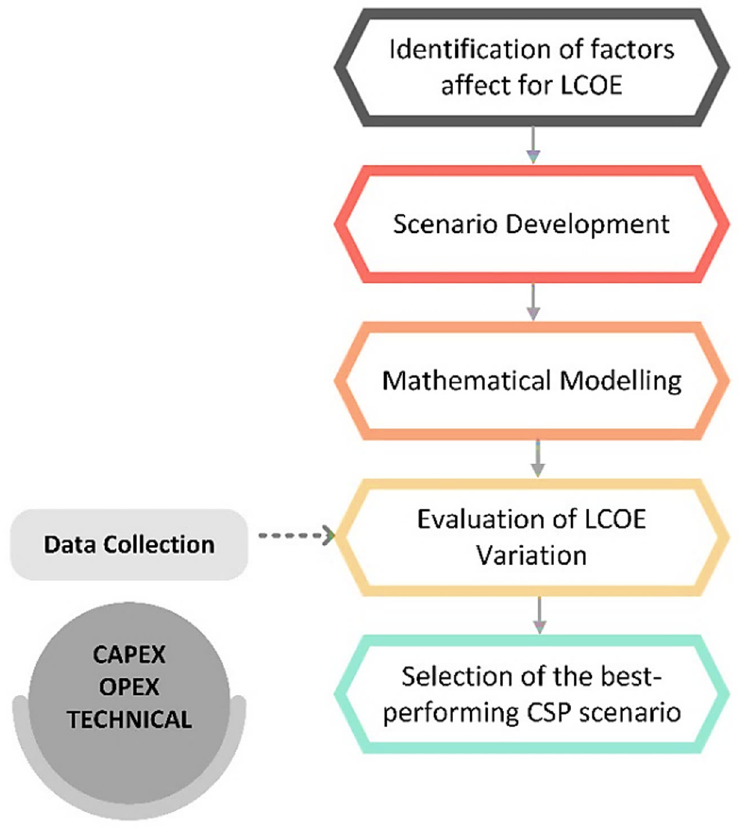
Figure 2. Evaluation methodology for LCOE variation.